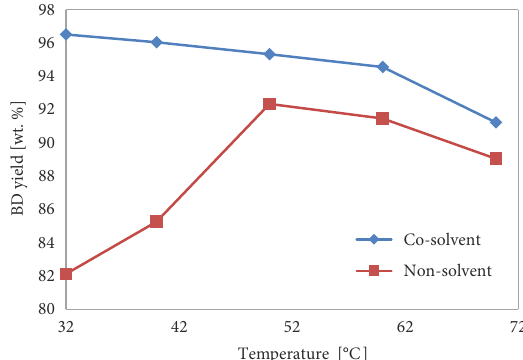
Figure 3. Influence of co-solvent to methanol volume ratio on BAO conversion